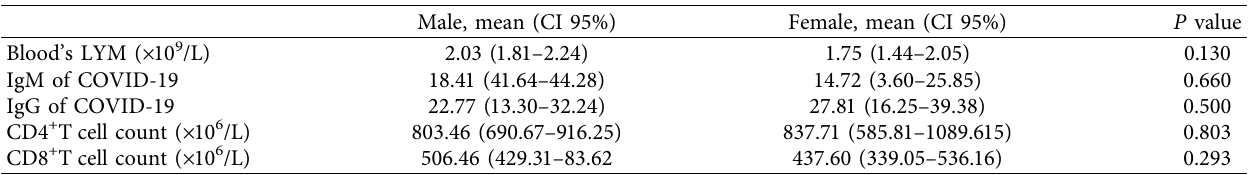
Table 2: Comparison of immunological tests in male and female nonsevere COVID-19